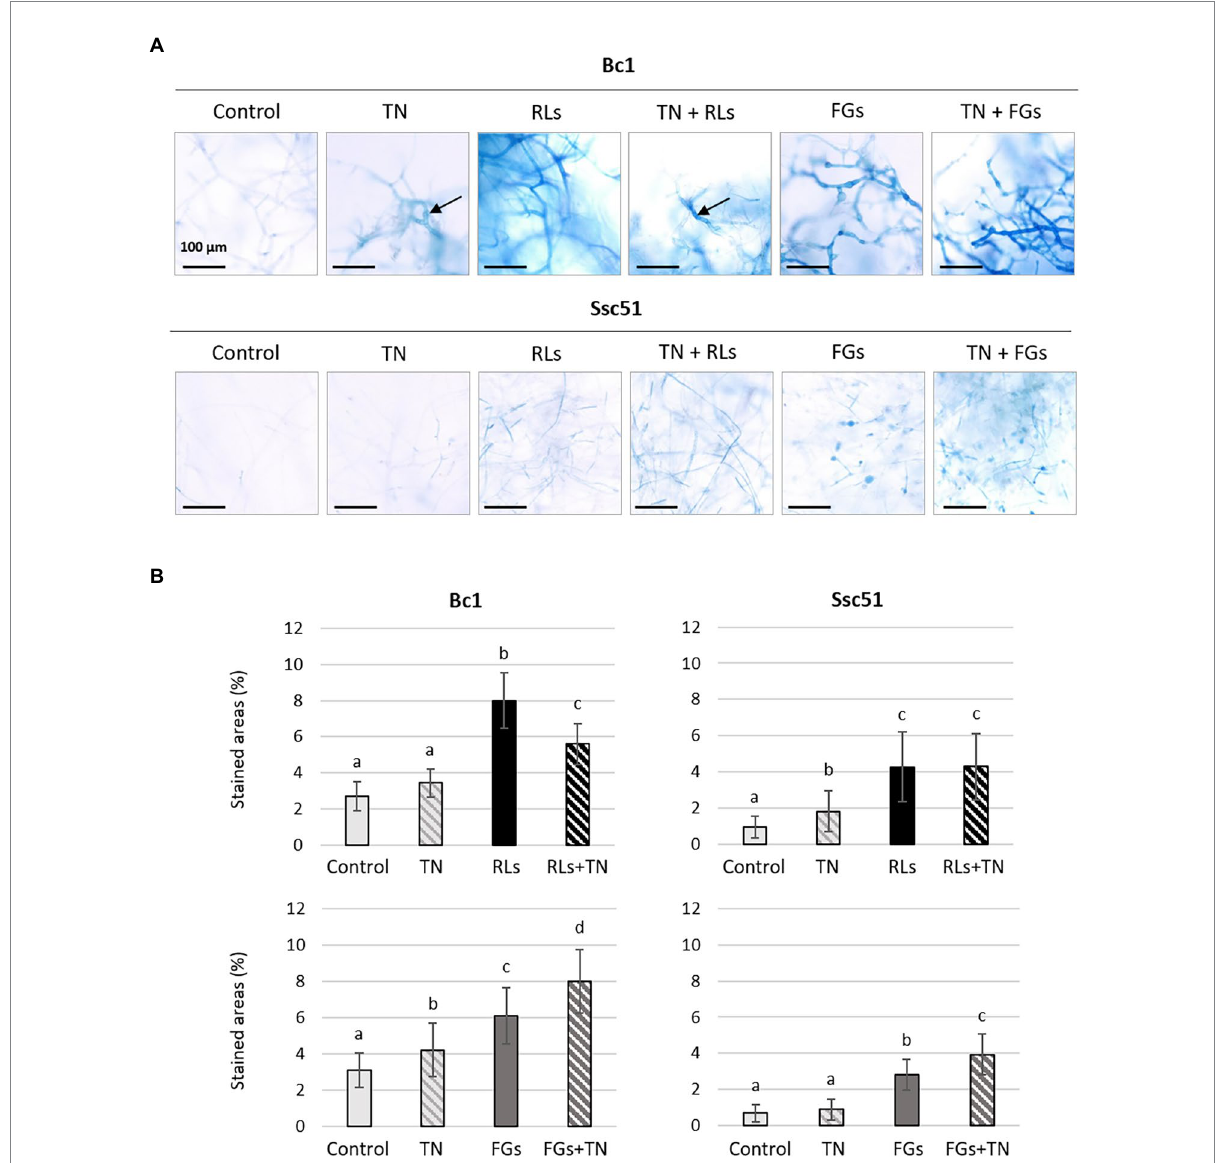
FIGURE 9 Evans blue dye coloration of Bc1 and Ssc51 mycelium after treatments with 25 μ g mL − 1 RLs or 50 μ g mL − 1 FGs alone or simultaneously with 1 mM TN. Light microscopy observations of stained mycelium. Scale bar: 100 μ m. Black arrows show hyphal enlargement (A) . Quantification of stained areas (%). Error bars represent standard errors. Letters indicate significant differences ( p < 0.05) between the groups (B)